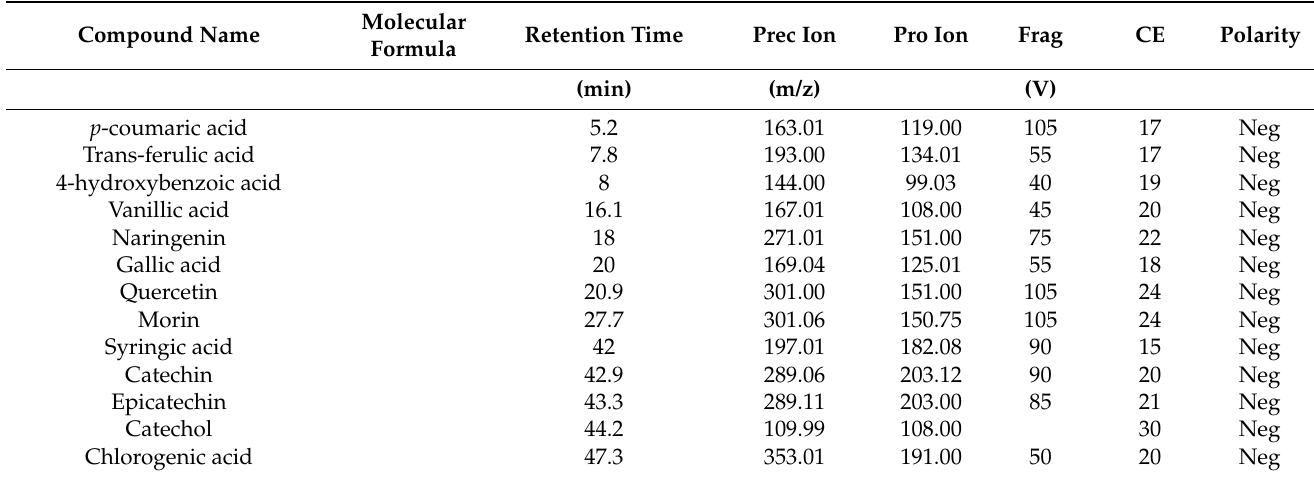
Table 3. LC-ESI-TQ-MS/MS-identified polyphenolic compounds of Tradescantia pallida .